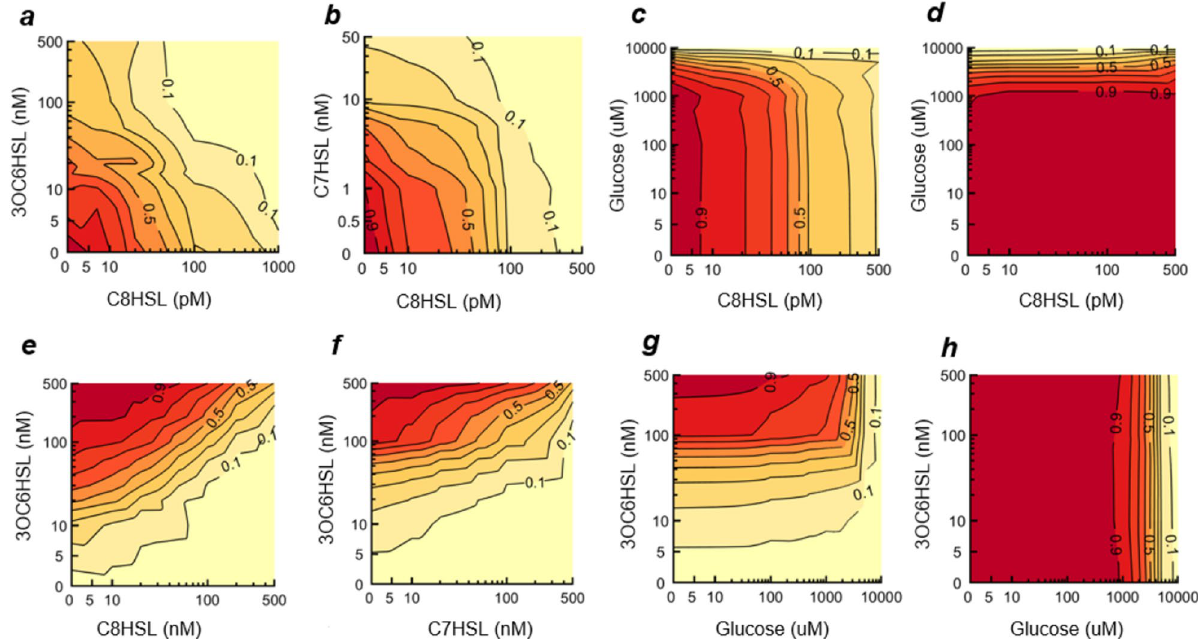
Figure 2. Population-average response of AinR/S and LuxI/R sensing systems. The mean (population- averaged) response of the qrr and lux reporters to environmental cues is measured using a well-plate reader. Contours show GFP fluorescence and growth behavior measured in bulk cultures for qrr and lux reporting strains under different combinations of HSL and glucose inputs. For the qrr reporter, contour plots show mean fluorescence in response to combinations of (a) C8HSL and 3OC6HSL, (b) C8HSL and C7HSL, and (c) C8HSL and glucose; (d) shows optical density (600 nm) following 10 h growth in C8HSL with glucose. For the lux reporting strain, contour plots show mean response to (e) 3OC6HSL and C8HSL, (f) 3OC6HSL and C7HSL, and (g) 3OC6HSL and glucose; (h) shows optical density (600 nm) following 10 h growth in 3OC6HSL and glucose. The labels on the contours are normalized relative to the maximum observed data value. Axis scales are linear below 10 concentration units and logarithmic above 10 units 48